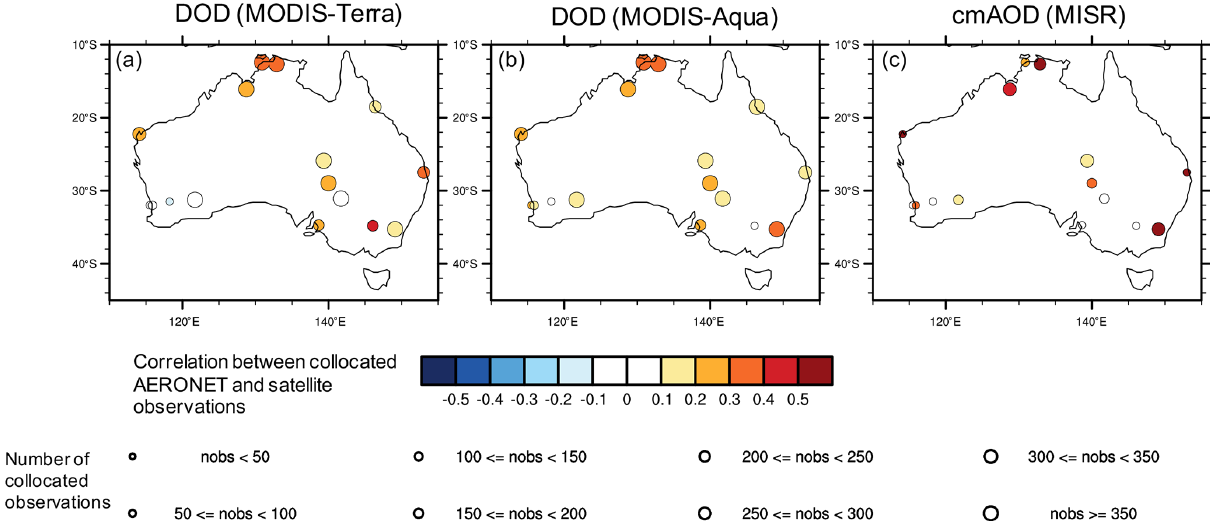
Figure 6. Correlation between colocated hourly cmAOD from AERONET and satellite measurements at 18 AERONET sites in Australia. The satellite measurements include (a) DOD from MODIS-Terra, (b) DOD from MODIS-Aqua, and (c) cmAOD from MISR. The sizes of the dots indicate the number of colocated observations. A missing circle in (c) indicates no collocation between MISR and AERONET observations.